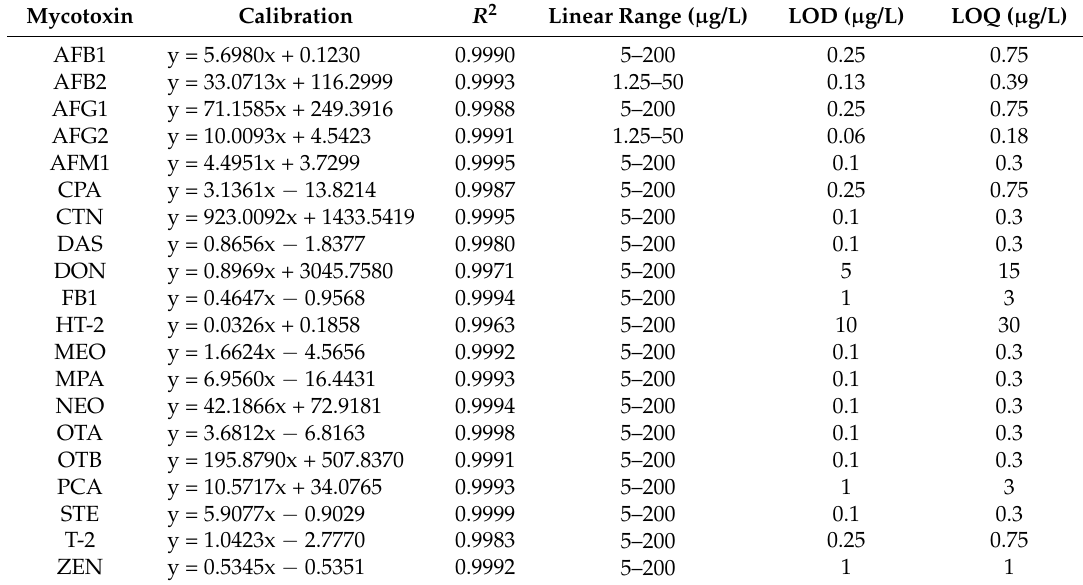
Table 4. Linear regression data, LODs and LOQs for 20 mycotoxins